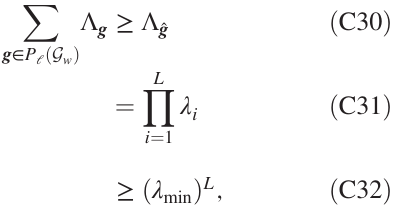
TABLE II. Edge coefficients λ α